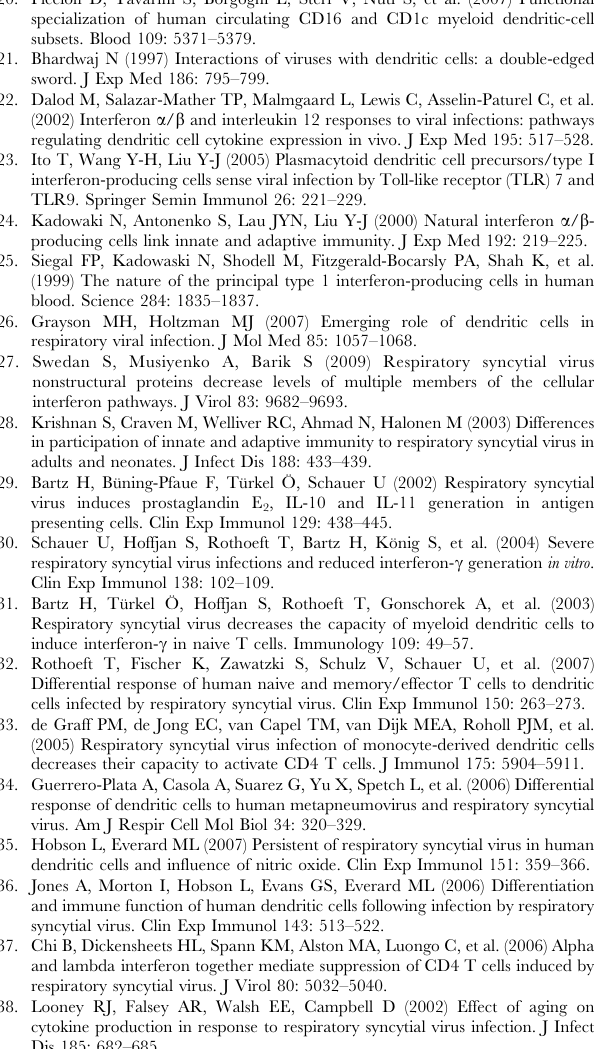
Table S7 Correlation Analyses (Spearman’s Rank Or- der) of pDC Cytokine/Chemokine Production. For each individual donor (data detailed in Table S3), cytokine and chemokine production by RSV-exposed pDC were correlated to each other. These analyses were performed using Spearman’s rank order test of correlation. Strong positive correlations are defined as r . 0 and p , 0.01 and are denoted by bold red values in gray shaded boxes while weak positive correlations are defined as r . 0 and 0.01 , p , 0.05 and are denoted by bold red values. Similarly, strong negative correlations are defined as r , 0 and p , 0.01 and